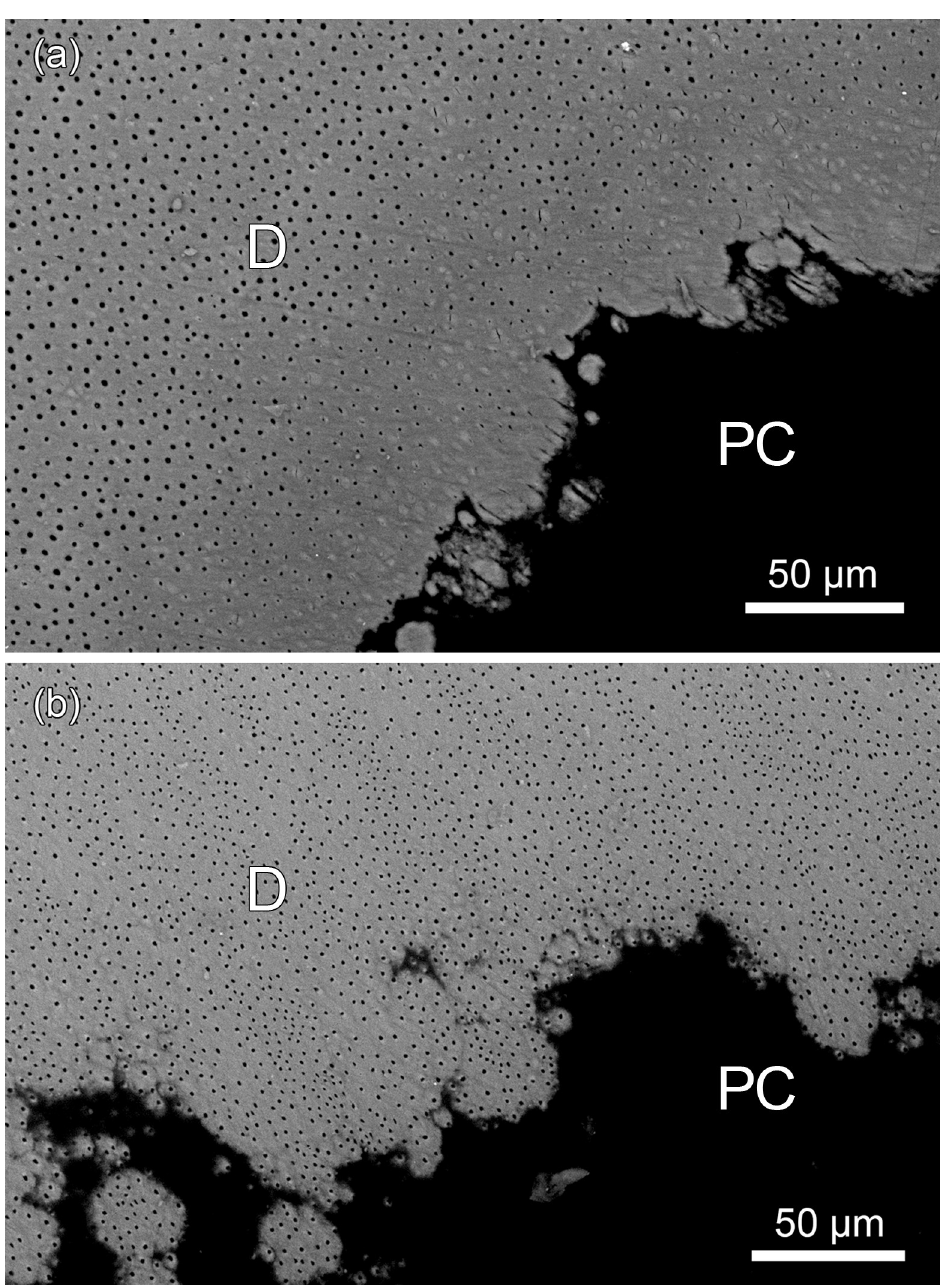
Fig 12. SEM-BSE images of polished cut surface showing the dentin overlying the pulp cavity in permanent maxillary canines of juvenile Baltic grey seals ( Halichoerus grypus grypus ). (a) Right maxillary C of specimen ZMUC 69 3 . Note occlusion of many dentinal tubules in juxtapulpal dentin by mineral deposits. As evidenced by its higher brightness, the material occluding the dentinal tubules is more highly mineralized than the surrounding intertubular dentin. PC: resin-filled pulp cavity. (b) Left maxillary C of specimen ZMUC CN 1157. No occlusion of dentinal tubules. D: dentin; PC: resin-filled pulp cavity. year of growth [47]. The interglobular dentin present in the canine of specimen ZMUC 69 3 , which was formed in the year of birth, is therefore considered a pathological feature.